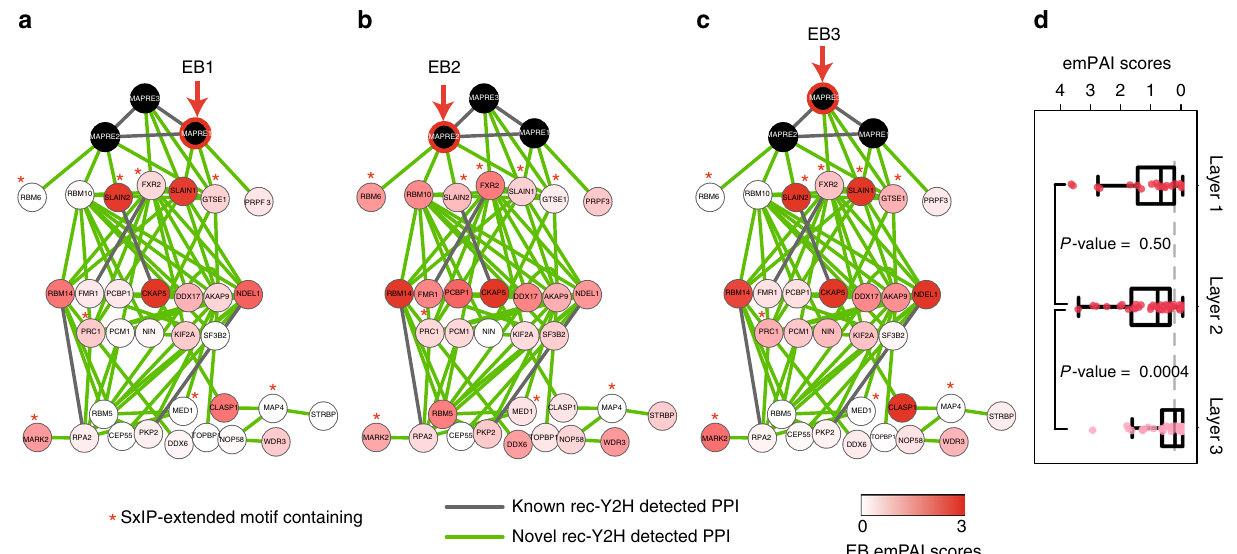
Fig. 5 rec-Y2H re fi nes the putative architecture of coprecipitated complexes. a – c Direct interaction networks of the microtubule end-binding proteins (EBs). The fi rst layer represents the direct EB-binding partners found in this screen. The second and third layers represent indirect binding partners, separated from the EBs by one or two nodes. All interactions depicted here were detected by rec-Y2H. Interaction pairs also annotated in PPI databases are shown as grey lines. Proteins having known EB interaction motifs (SxIP) are marked with a red asterisk. We used an extended SxIP-9AA motif de fi nition with the following rules: (1) X 1 − X 2 − [ST] − X 3 − [IL] − P − X 4 − X 5 − X 6 ; (2) X 1 − X 4 , at least one basic amino acid (R/H/K); and (3) X 1 − X 6 , no acidic amino acid (D/E) 11 . Nodes are coloured according to the protein abundance in the pull-down complex (emPAI score) 11 with a EB1 as bait, b EB2 as bait, and c EB3 as bait. In all cases, we could not fi nd the alternative LxxPTPh EB interaction motif 32 . d emPAI scores for each layer. The box of the box plot illustrates the median, upper, and lower quartiles for emPAI scores. The data from all three EB protein pull-downs were combined in the box plot representation and each data point is represented as a dot. The grey-dotted line indicates the median emPAI score of Layer 3 proteins. P -values were calculated by Wilcoxon